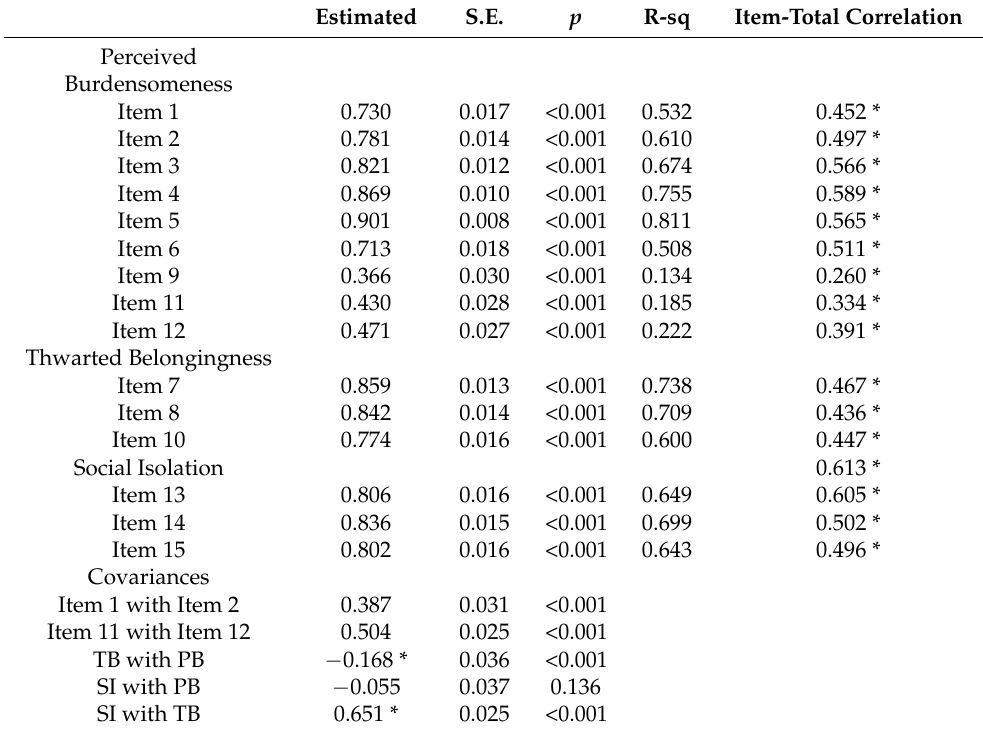
Table 4. Model estimated factor loadings, covariances, p -value and R-squares in Sample 2 ( n = 931). Estimated S.E. p R-sq Item-Total